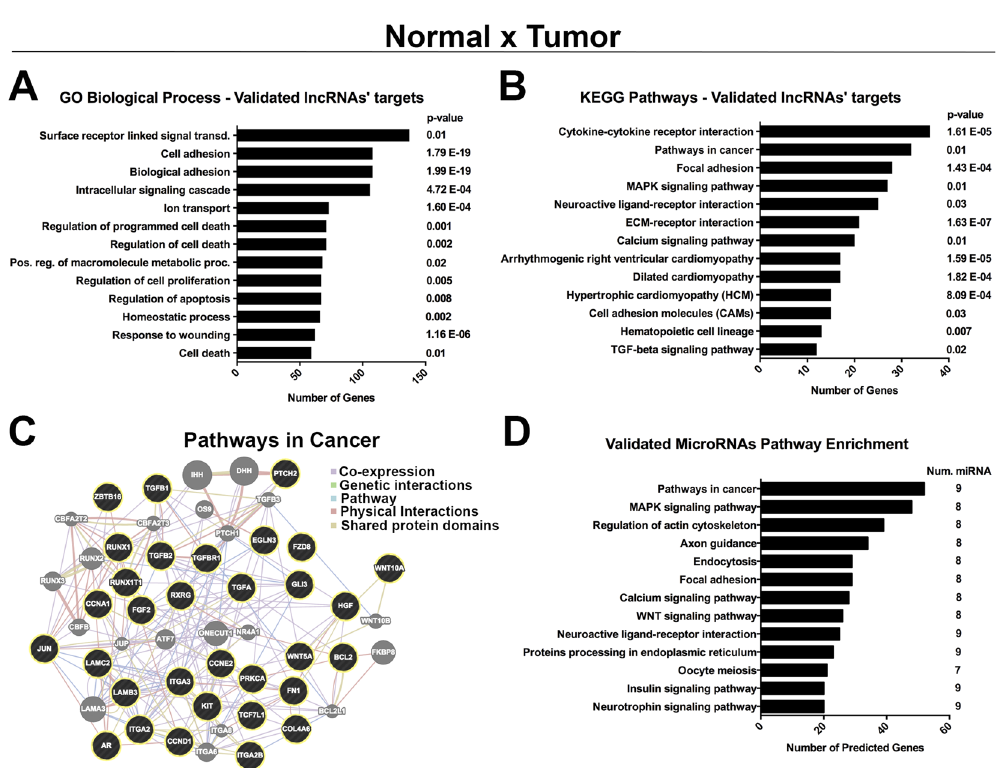
Figure 3. Indirectly validated targets of the DE lncRNAs between N × T are involved in cancer-related processes. ( A ) GO biological processes and ( B ) KEGG enriched pathways of the indirectly validated mRNA targets of the DE lncRNAs between N × T. ( C ) Proteins’ network of genes linked to the pathways in cancer, where black circles are validated targets and grey circles are connective proteins. ( D ) KEGG Pathways enrichment of the indirectly validated microRNAs targets of the DE lncRNAs between N ×